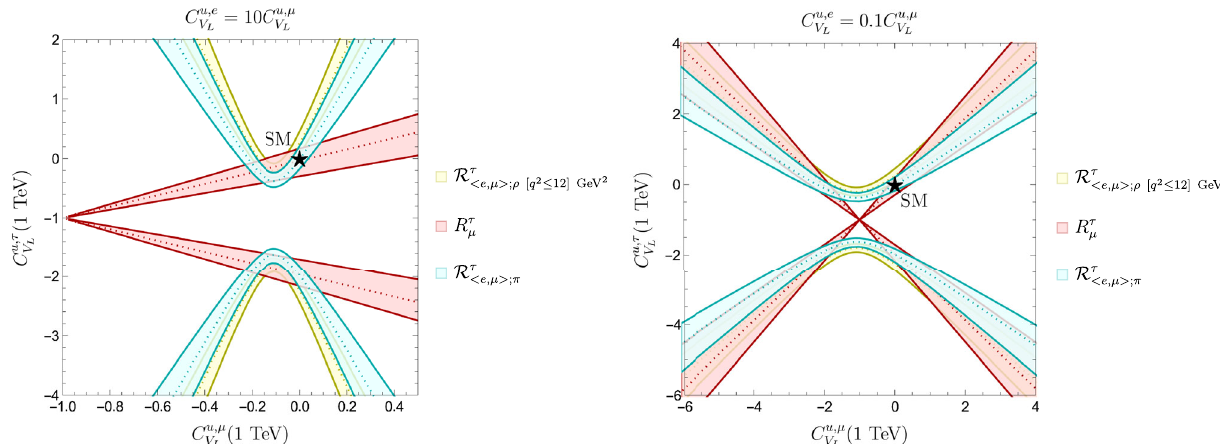
,μ – C u ,τ plane following from the observables defined in the text. The left panel corresponds to the assumption V L V L = 0 . 1 C u ,μ V L V L